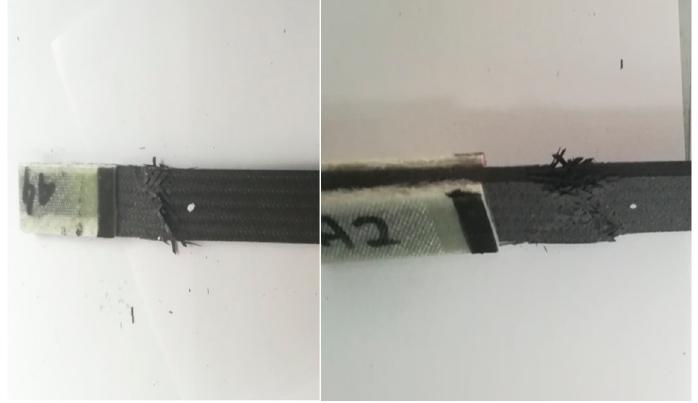
Figure 13. Appearance of samples from series A after tensile bench testing.